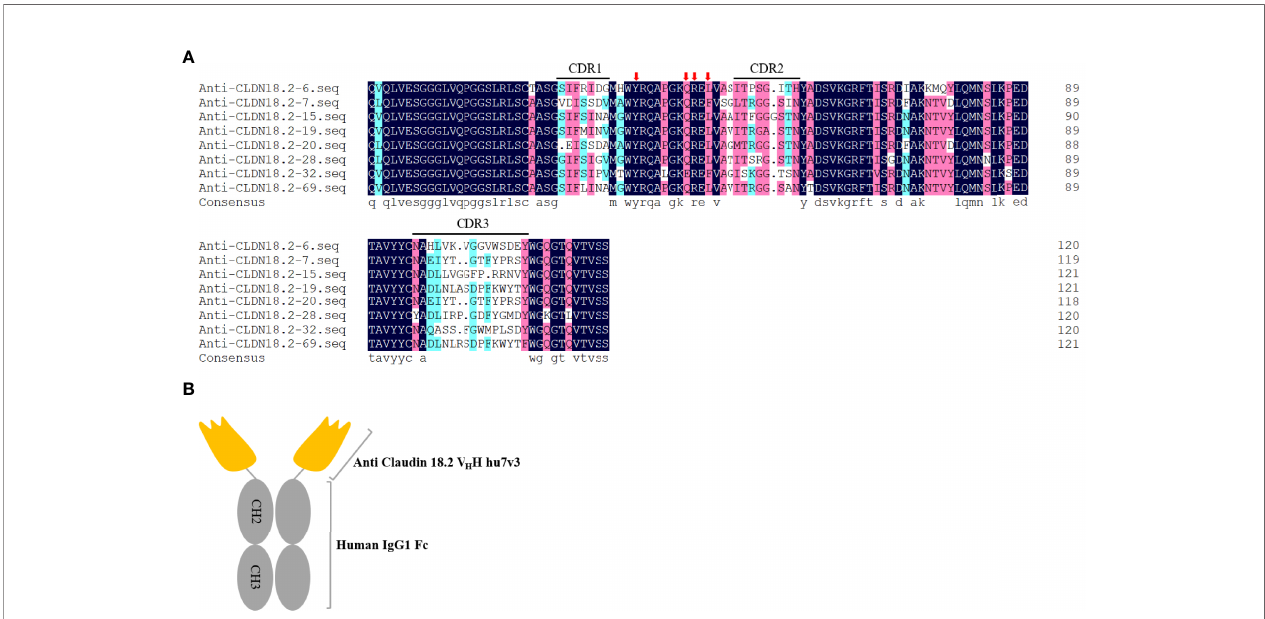
FIGURE 1 | Isolation of anti-CLDN18.2 VHH variants. (A) Amino acid sequences of anti-CLDN18.2 VHHs. Sequences are presented using one-letter amino acid abbreviations. DNAMAN was used to generate the alignment. Complementarity determining regions (CDRs) are shown. Four hydrophilic amino acids (Tyr42, Glu/ Gln49, Arg50 and Leu/Phe52) critical for humanization are indicated with red arrows. (B) Schematic composition of hu7v3-Fc structure in this study. Anti CLDN18.2 VHH hu7v3 is indicated in orange, and the human IgG1 Fc domain including the hinge, CH2 and CH3 domains is indicated in